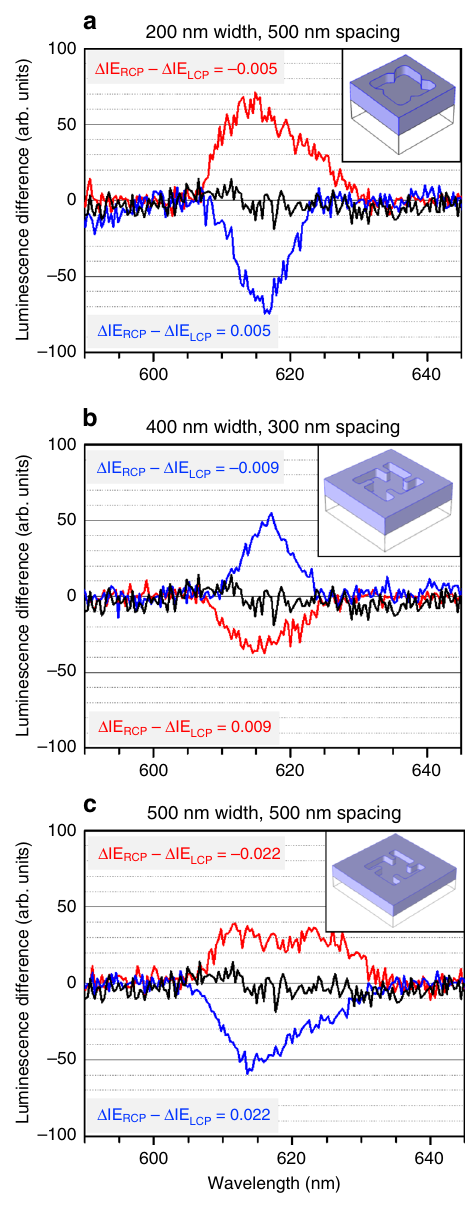
Fig. 4 Luminescence difference spectra for meta fi lms. a , c show the difference in luminescence RCP – LCP for the LH nanostructure (red), RH nanostructure (blue) and equivalent unstructured surface (black). The LH and RH structures show opposite differences at the 7 F 2 peak. The width and spacing labels equate to the lateral size and interstitial spacing of the nanostructures, respectively, Δ IE RCP − Δ IE LCP values for each handedness of structure are shown (red and blue for LH and RH structures, respectively), demonstrating the same equal and opposite behaviour as the difference spectra. Insets show structure geometries not drawn to scale (see Supplementary Fig. 3 for scale